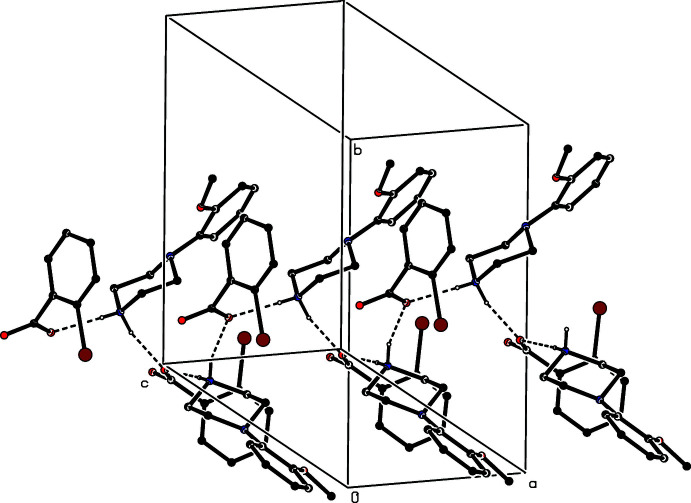
Part of the crystal structure of compound (VI) showing the formation of a (4) chain running parallel to [100], in which ion pairs are linked by a further N—H⋯O hydrogen bond. Hydrogen bonds are drawn as dashed lines and, for the sake of clarity, the H atoms bonded to C atoms have been omitted.